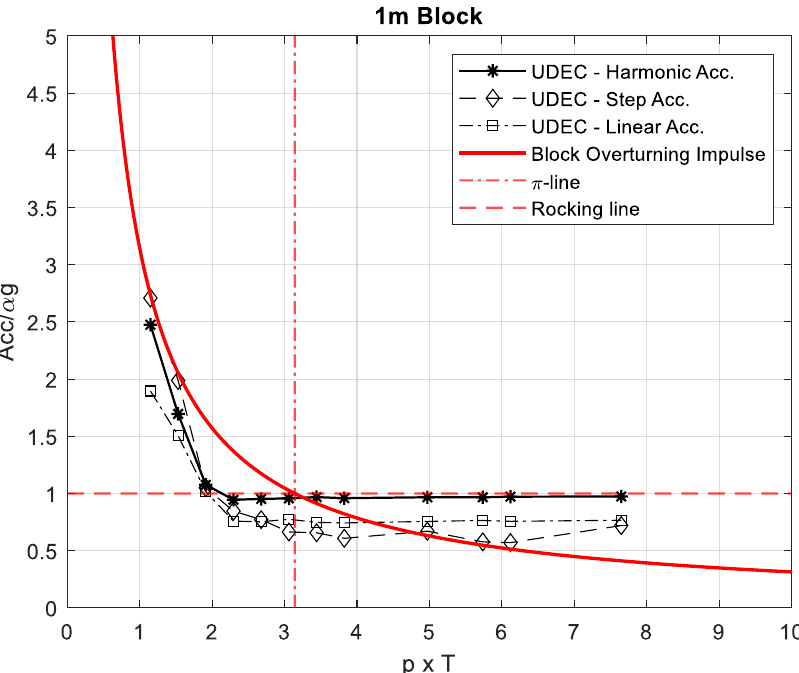
Figure 6. Normalized numerical results for all three types of pulses for the 1 m block.